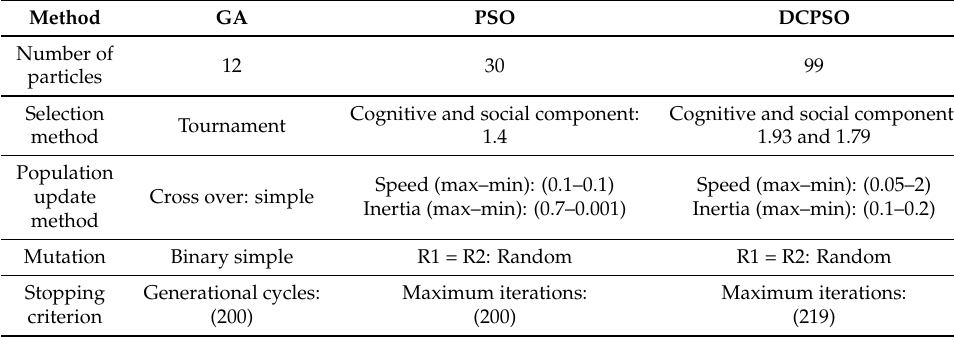
Table 2. Parameters of the proposed master–slave